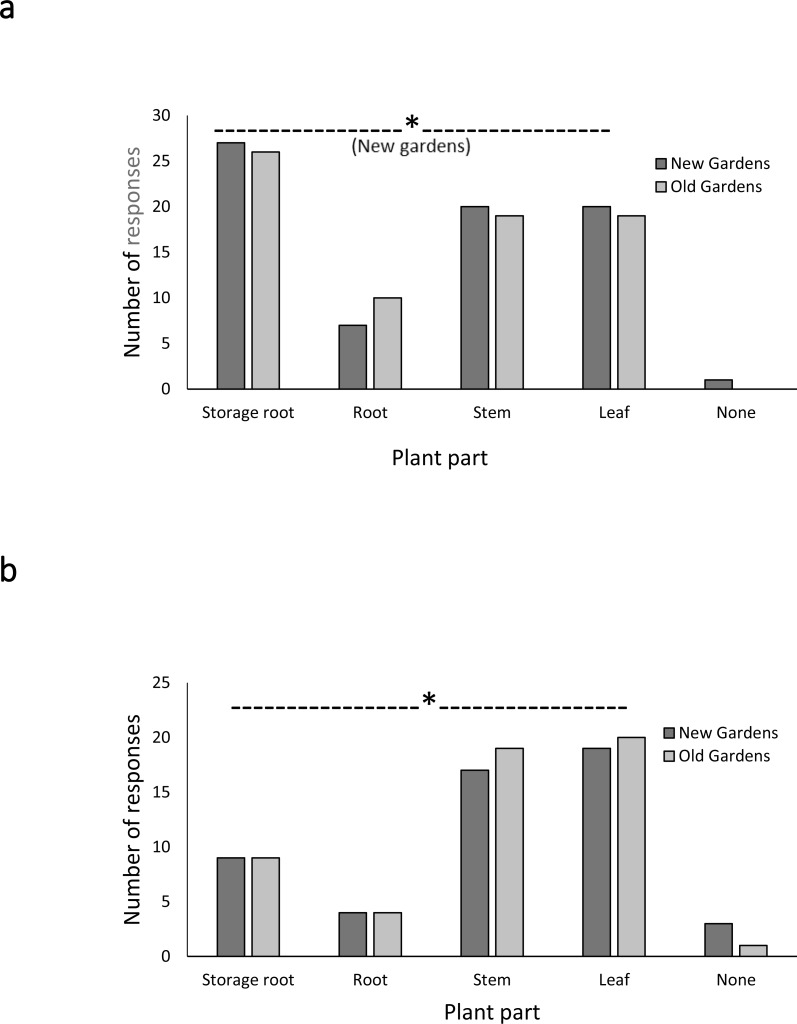
Farmers’ responses on whether and where they observe damage by pests (A) and diseases (B).(Means are the number of farmers mentioning a given concern and are non-mutually exclusive, some farmers mentioning one, and some multiple plant portions.) (Chi-square tests compared plant portions within each garden age: PESTS, new gardens, X2 = 7.849, df = 3, p = 0.049; old gardens, X2 = 4.524, df = 3, p = 0.201). DISEASES, old gardens: X2 = 8.544, df = 3 p = 0.036; old gardens, X2 = 9.9444, df = 3, p = 0.0190